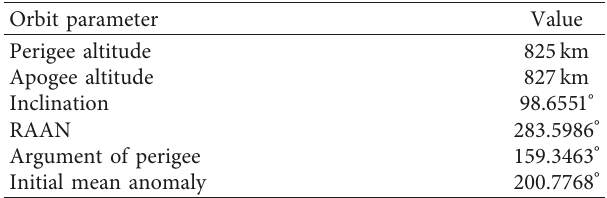
Table 1: Parameters of the orbit.